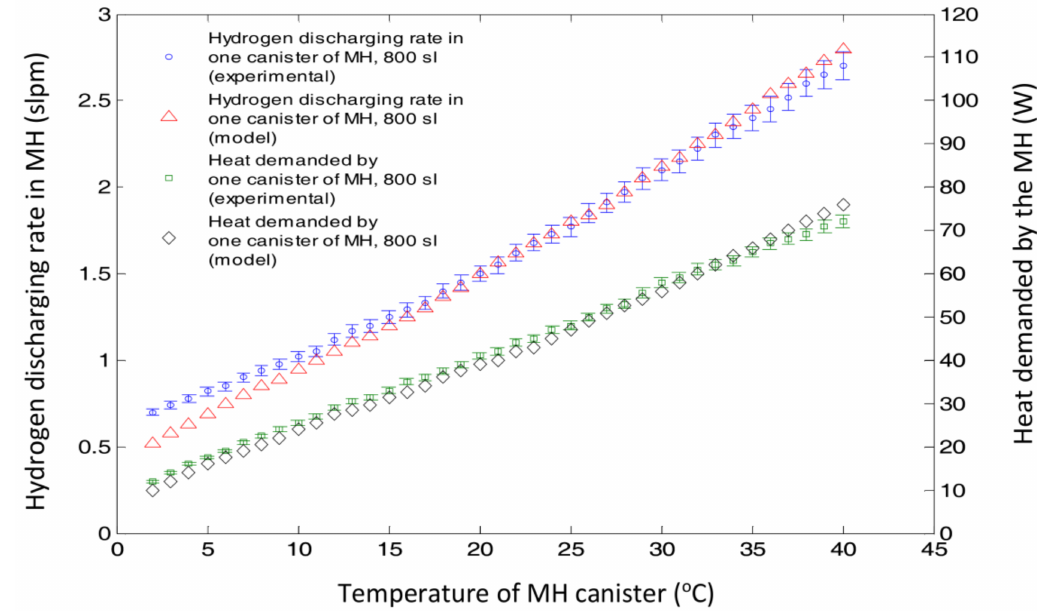
Figure 10. Hydrogen discharge rate in MH canister (MmNiMnCo, 800 sl) and heat demanded by the MH as a function of MH temperature in both the experiments and the model; maximum 1% error is associated with the data for flow rate and 1.5% error associated with heat